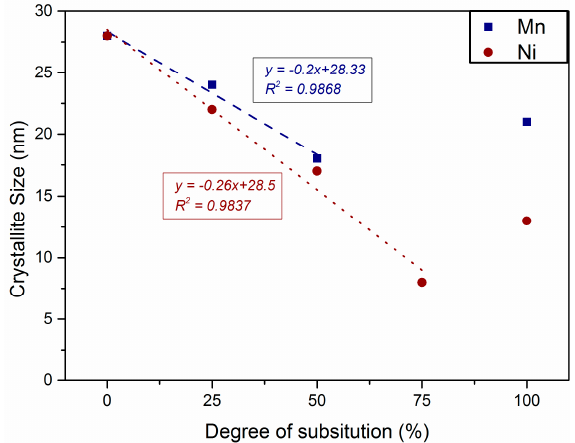
Figure 2. Crystallite size as a function of the degree of substitution for LaCo 1 – x Mn x O 3 and LaCo 1 – y Ni y O 3 perovskites.